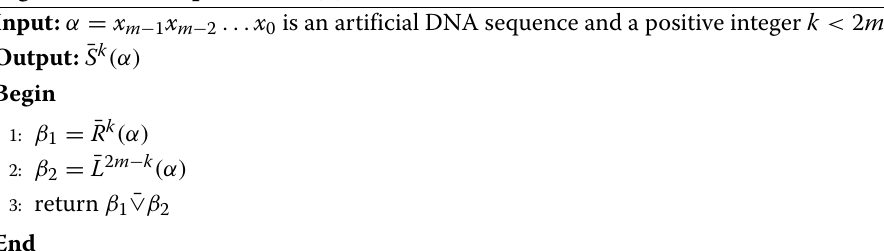
Algorithm 9 The operation